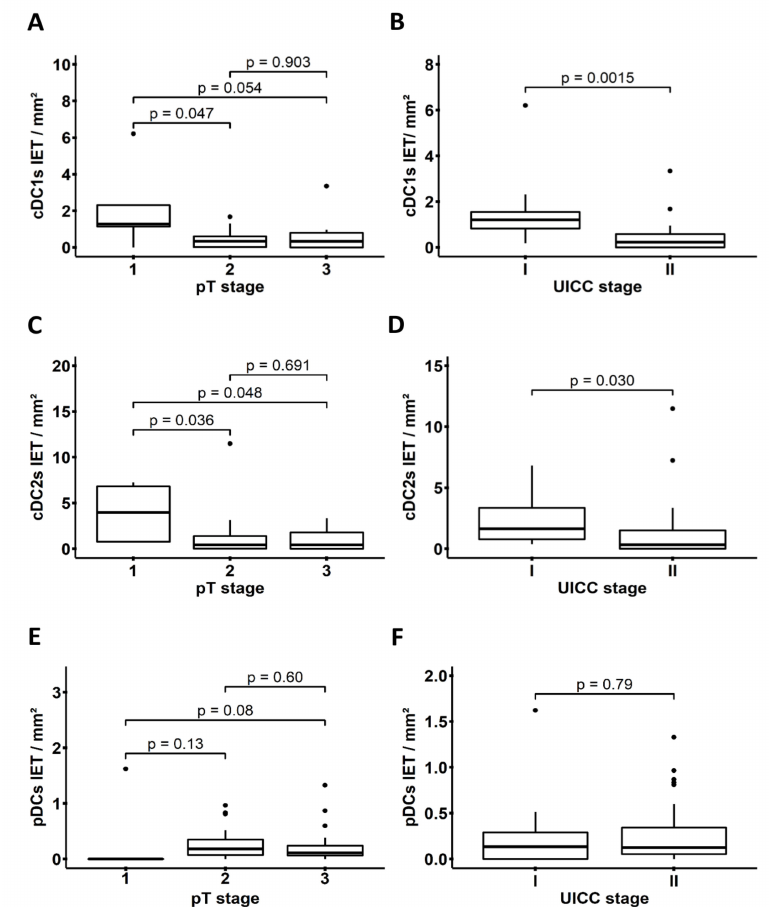
Figure 3. Frequency of intraepithelial tumor (IET) area-infiltrating dendritic cell (DC) subsets across distinct pathological tumor (pT) and Union for International Cancer Control (UICC) stages of pan- creatic ductal adenocarcinoma (PDAC) patients. Boxplots show the density of IET-infiltrating con- ventional DCs type 1 (cDC1s) ( n = 40), type 2 (cDC2s) ( n = 40), and plasmacytoid DCs (pDCs) ( n = 58) at different ( A , C , E ) tumor stages or ( B , D , F ) UICC stages. p values were calculated using the Mann–Whitney U test, and p ≤ 0.05 was considered